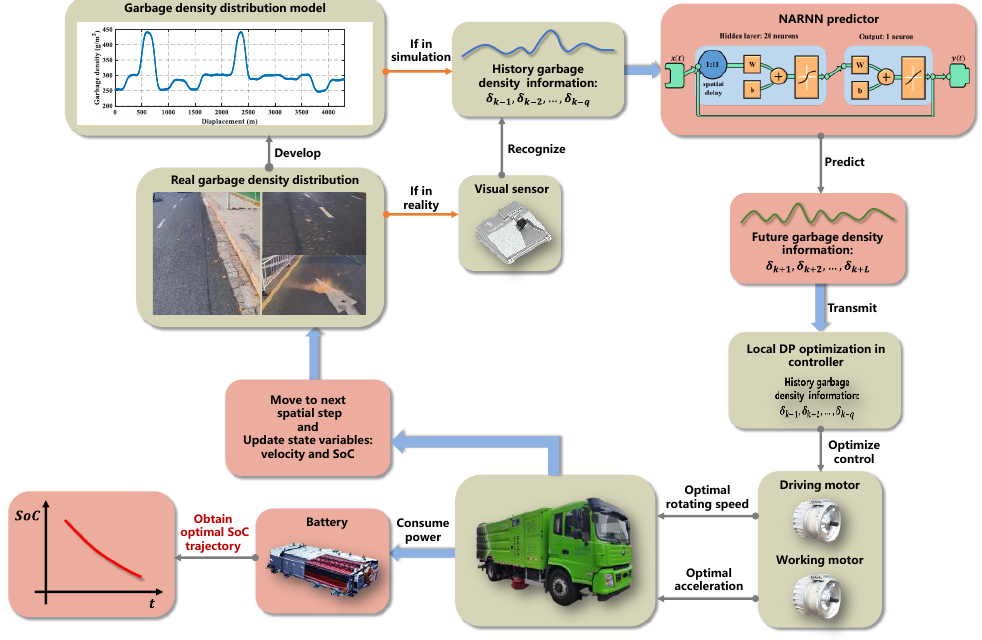
Figure 22. The AMPC based EMS.